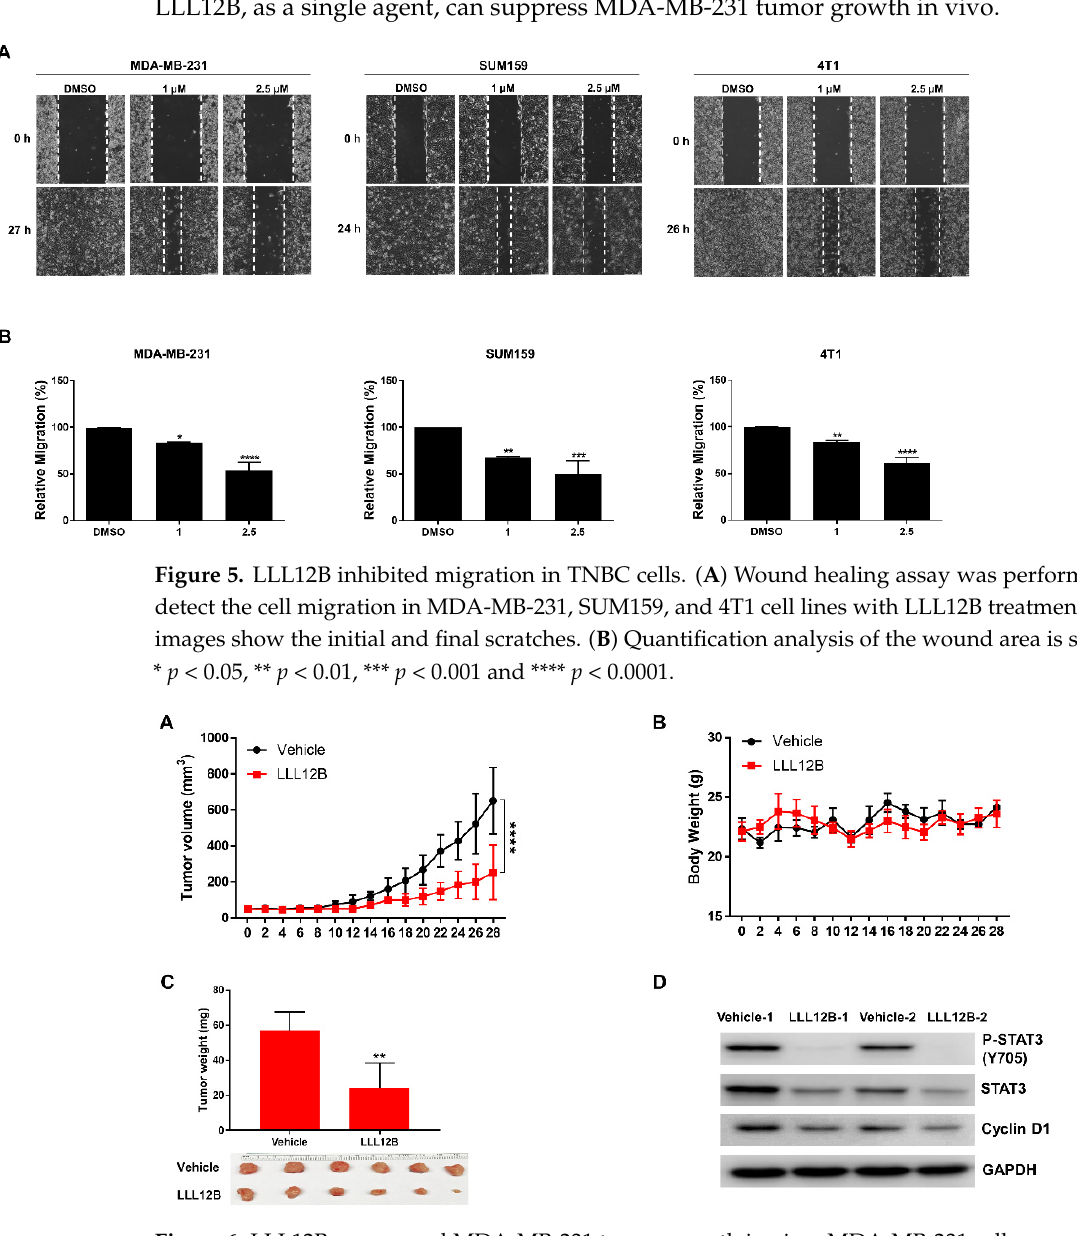
Figure 4. LLL12B suppressed colony formation of TNBC cells. MDA-MB-231 ( A ), SUM159 ( B ), and 4T1 ( C ) cells were seeded in a 6-well plate and treated with DMSO or LLL12B for 24 h and recovered in a drug-free culture medium for 7 days. Representative images of colony formation are shown in the left panel and the colony number was quantified and is shown in the right panel. ** p < 0.01, *** p < 0.001 and **** p < 0.0001.